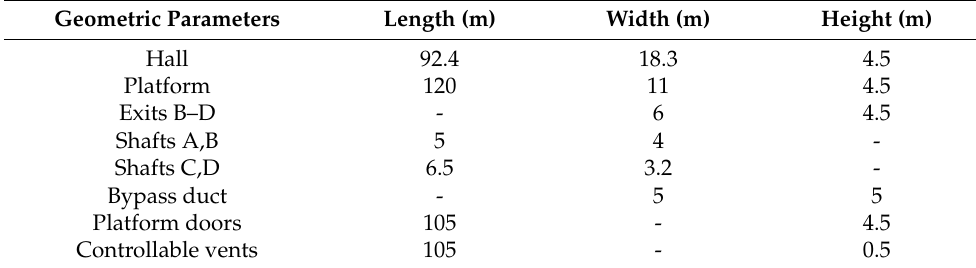
Table 1. Detailed geometric parameters of the Zhangmatun subway